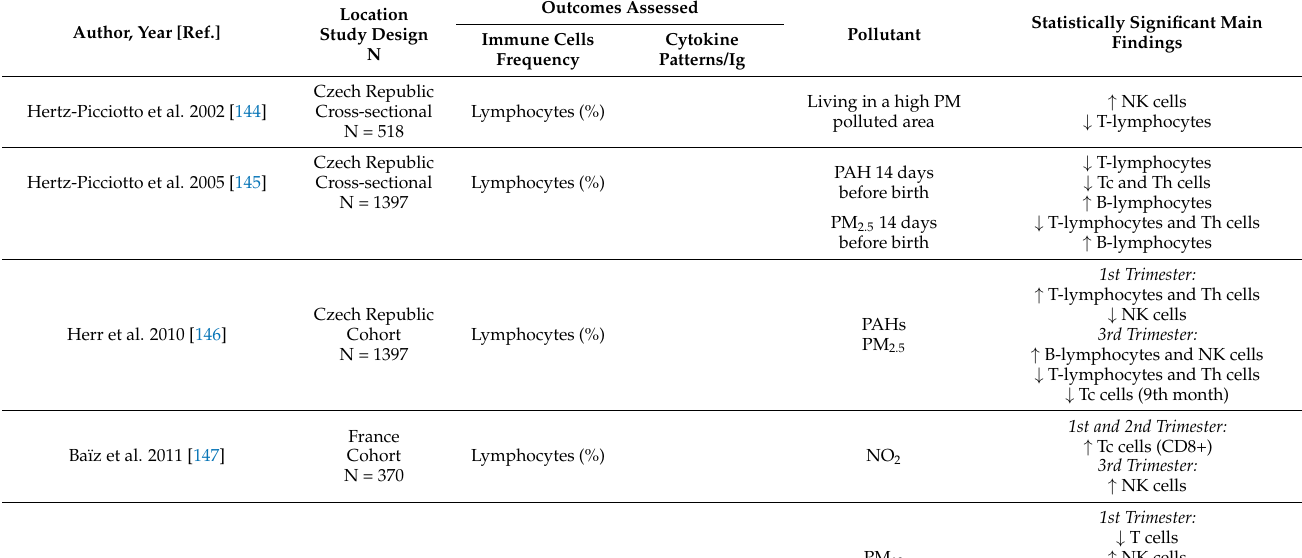
Table 7. Prenatal exposure to outdoor air pollutants and changes in the immune system in cord blood of neonates (authors ordered by year and then